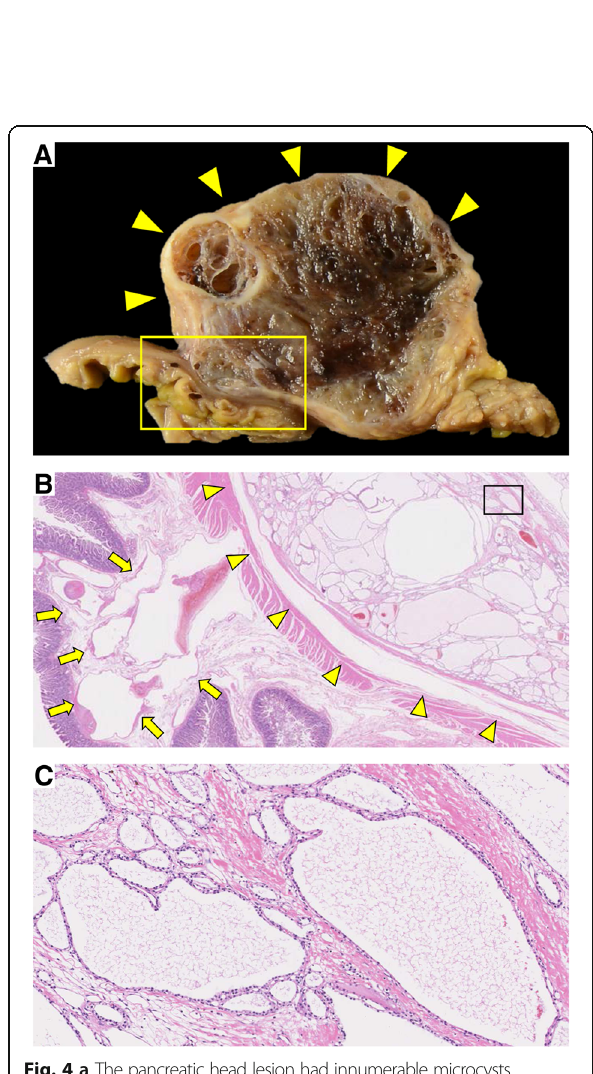
Fig. 4 a The pancreatic head lesion had innumerable microcysts (arrowheads). b Expansion of the square area of ( a ). The border between SCN and duodenum (arrowheads). The abnormal vessels in the duodenal mucosa (arrows) (HE). c Expansion of the square area of ( b ). The cyst locules lined by epithelial cells with round central nuclei